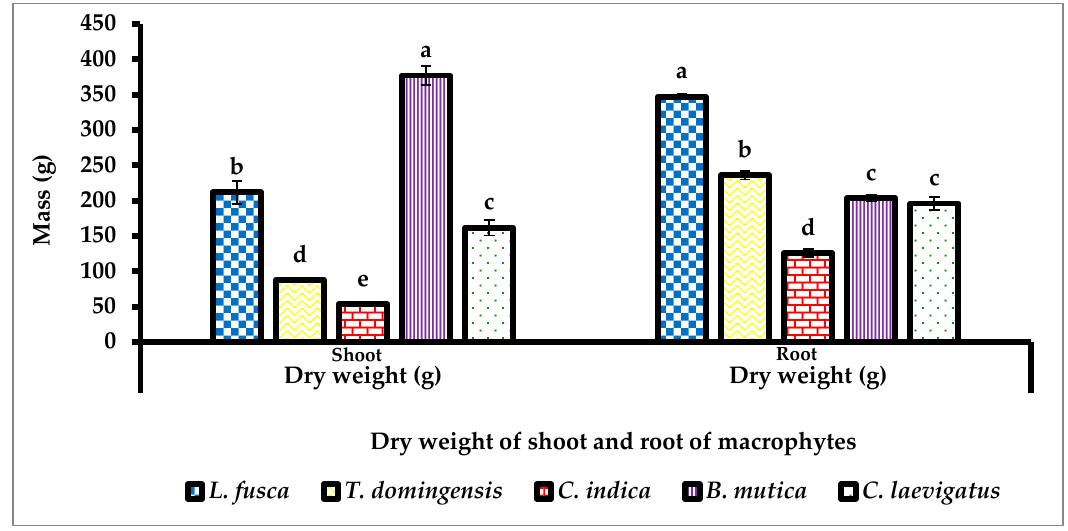
Figure 5. Biomass production of aquatic macrophytes in constructed wetlands fed with tannery effluent. Error bars indicate standard deviation among three replicates. Labels (a)–(e) indicate statistically significant differences ( p < 0.05) among plant species for shoot and root dry weight at a 5% level of significance.